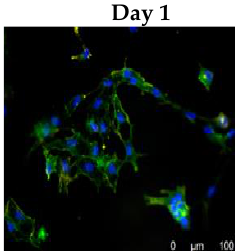
Figure 17. Fluorescent images of VICs in middle layer. Adapted with permission from ref. [231].